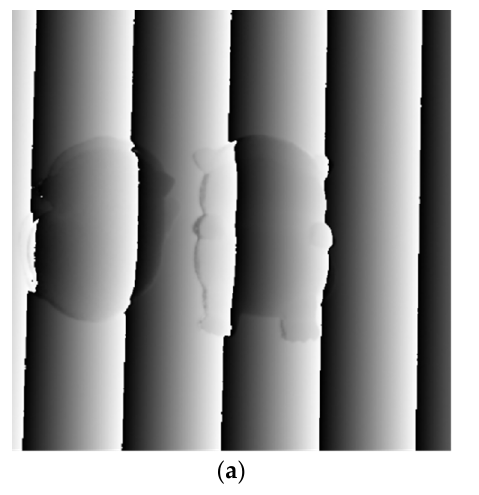
Figure 5. The wrapped phase maps of the two frequencies. ( a ) The high frequency wrapped phase map; ( b ) the low frequency wrapped phase map. map; ( b ) the low frequency wrapped phase map.